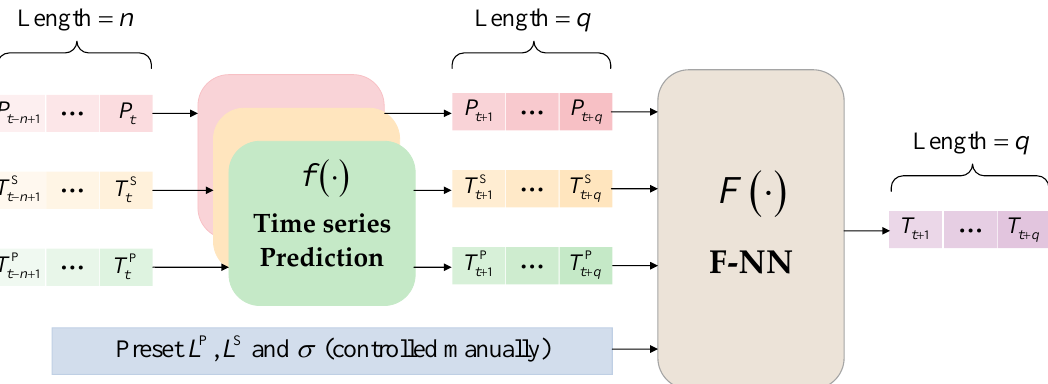
Figure 2. Schematic diagram of the prediction of a valve’s cooling water temperature.